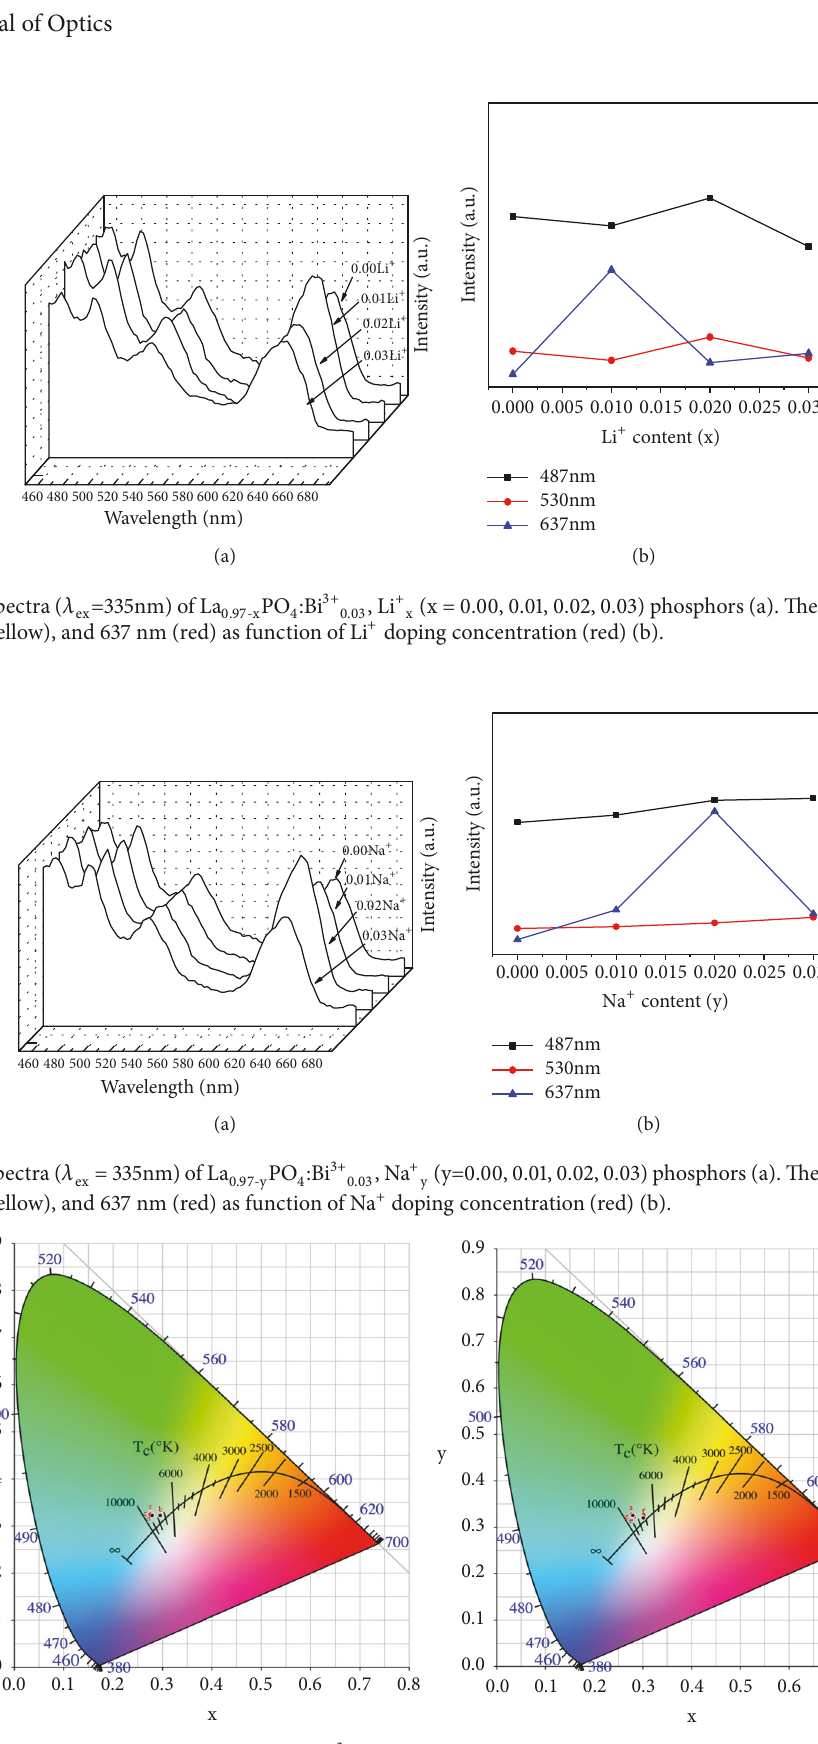
PO 4 :Bi 3+ 0.03 , Li + x , Na + y (x = 0.00,0.01,0.02,0.03, y = 0.00,0.01,0.02,0.03 ) - x - y